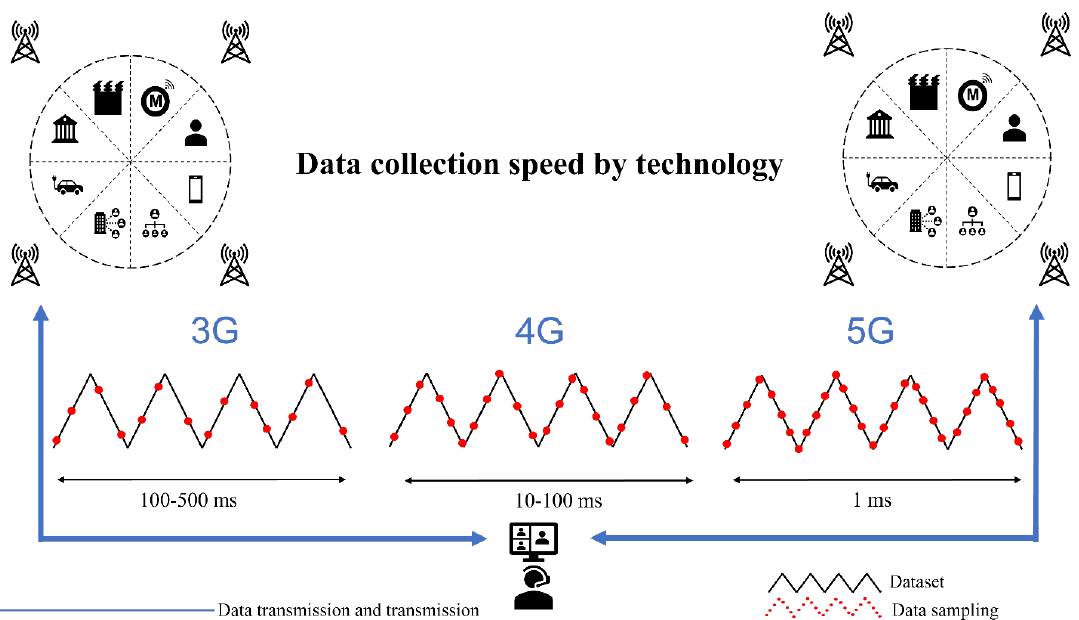
Figure 6. Data collection speed by technology.